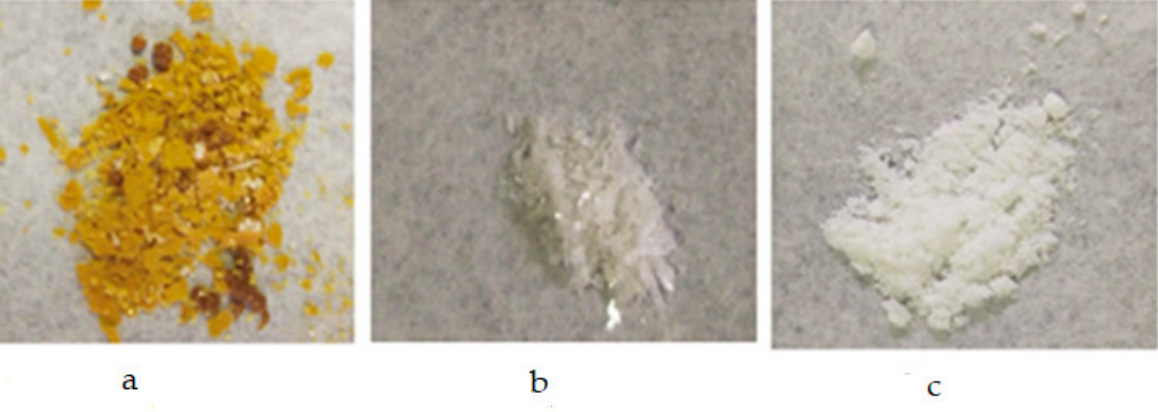
Figure 9. Organoleptic appearance of andrographolide extract ( a ), isolate after purification ( b ), and standard ( c ).